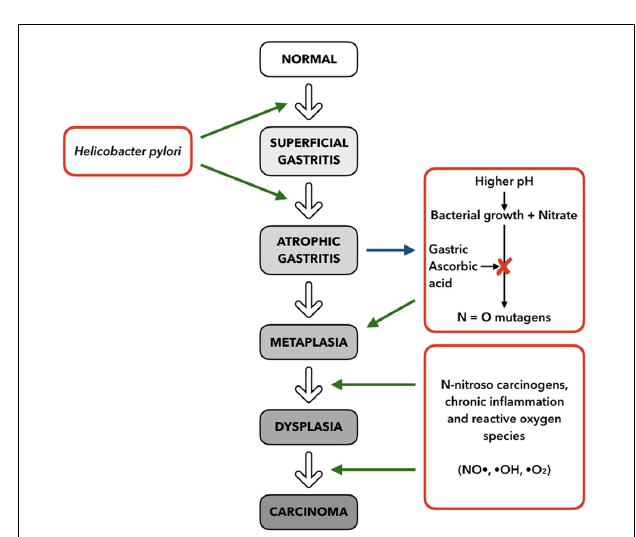
FIGURE 4 | Multistep model for progression of gastric cancer, based on stimuli and mechanisms (right and left) interacting with the histopathologic Correa Cascade (center) , from superficial gastritis to carcinoma (adapted from Fox and Wang, 2001).